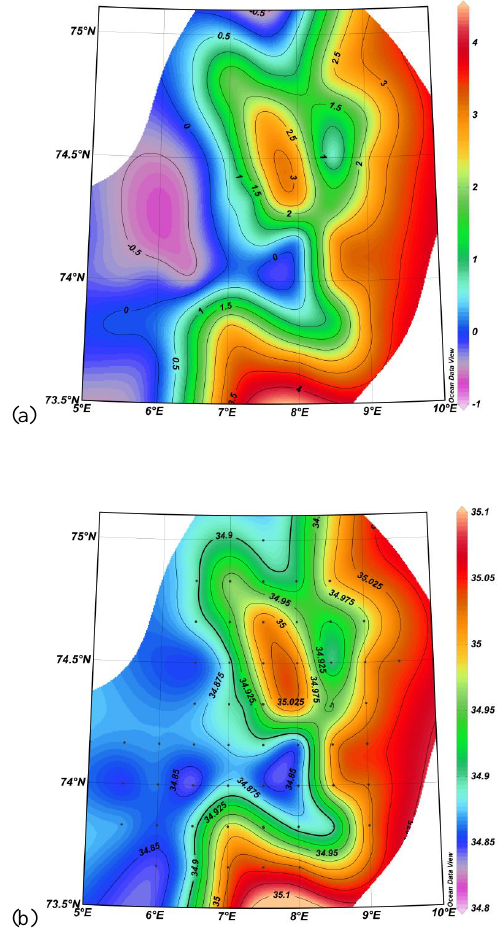
Fig. 10. Summer 1996. (a) Temperature and (b) salinity at Figure 10. Summer 1996. (a) Temperature and (b) salinity at 200 dbar. 5